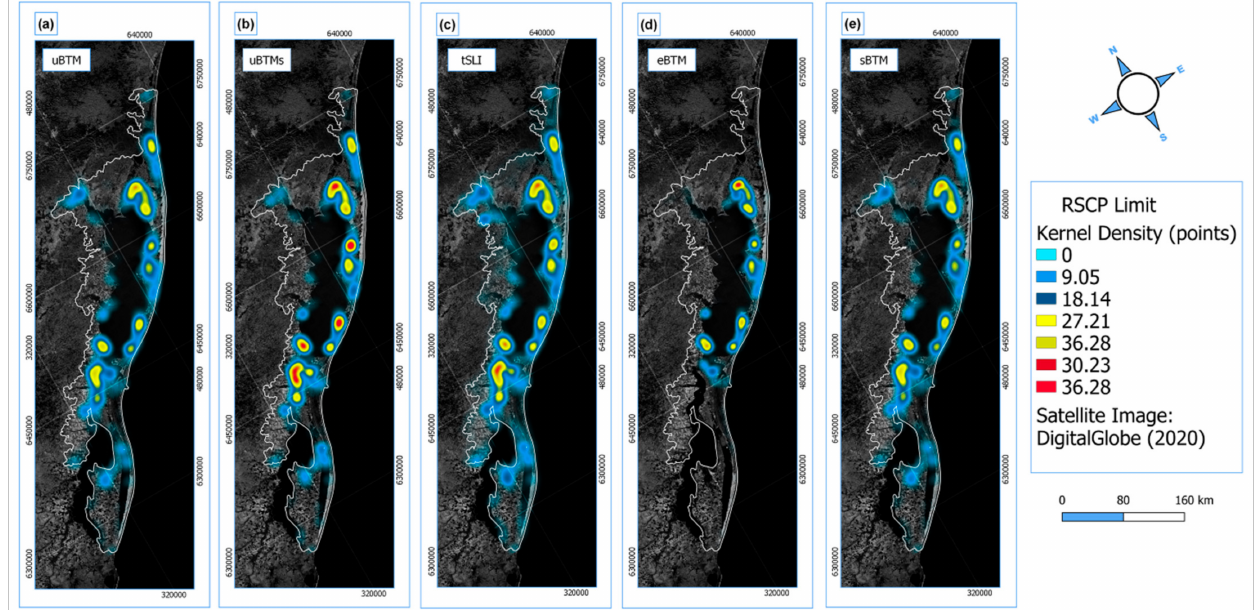
Figure 6. Spatial distribution through Kernel Density for the totally of Rio Grande do Sul coastal plain. ( a ) Uncertainty Bathtub model (uBTM). ( b ) Uncertainty Bathtub model smoothed (uBTMs). ( c ) Terrset sea-level impact (tSLI). ( d ) Enhanced Bathtub model (eBTM). ( e ) Simple Bathub model